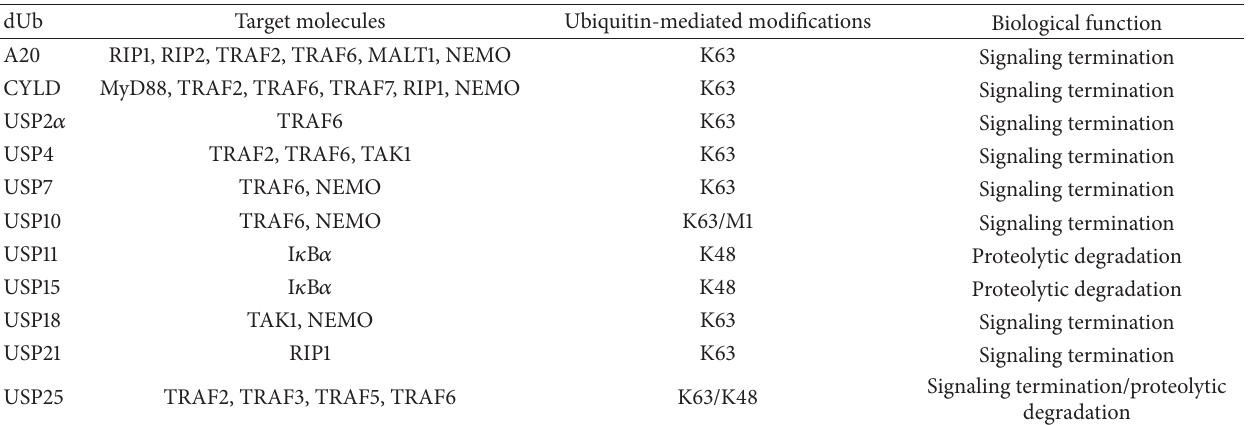
Table 3: Negative regulators of TLR signaling involved in